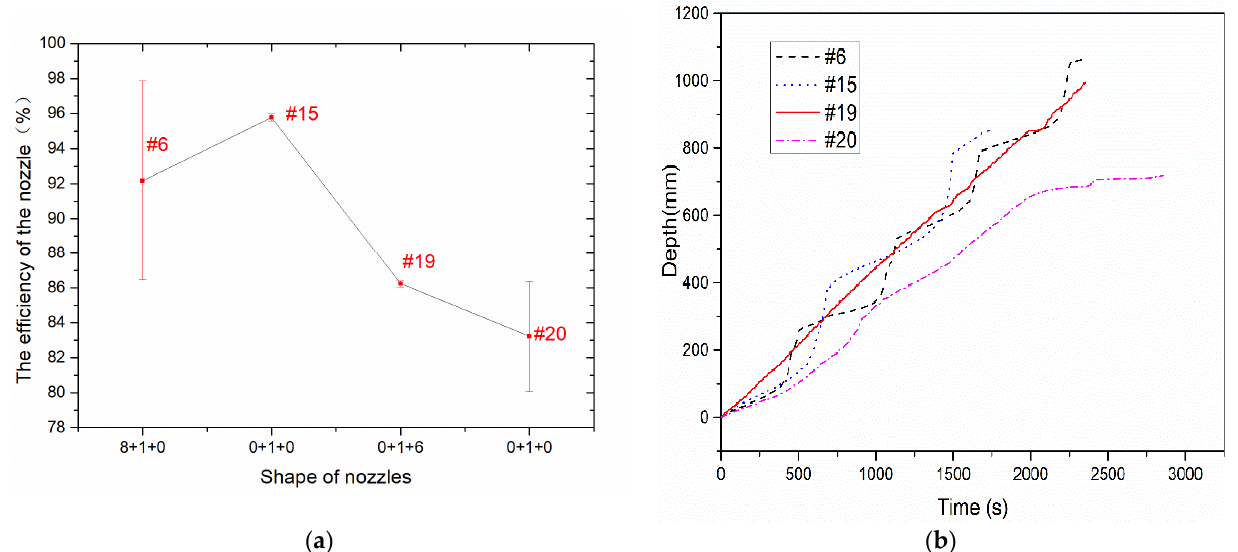
Figure 12. Results of comparison between nozzles of different types: ( a ) average efficiency vs. nozzle type; ( b ) penetration curves.